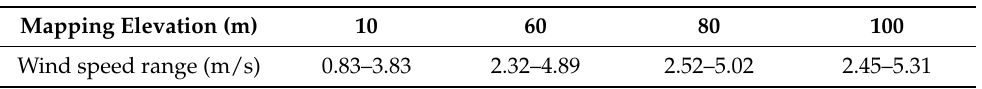
Table 7. The wind speed ranges of the mesoscale maps of the coastal and near-coastal areas of